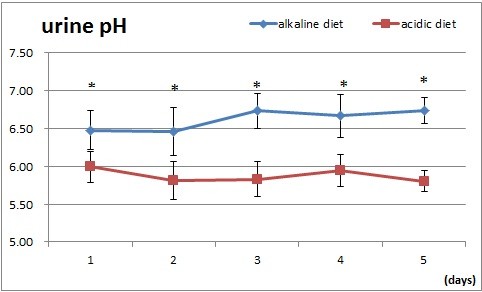
Effect of acidic (square) and alkaline (diamond) diets on urine pH. Data are presented as mean ± SD. Asterisks indicate the statistical significance between the two groups (p < 0.002).